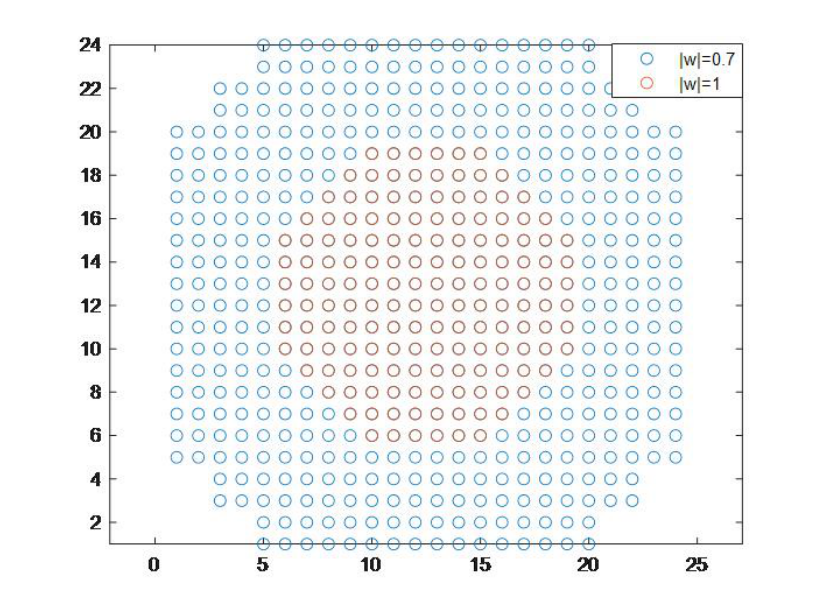
Figure 6. Weights distribution of the array.